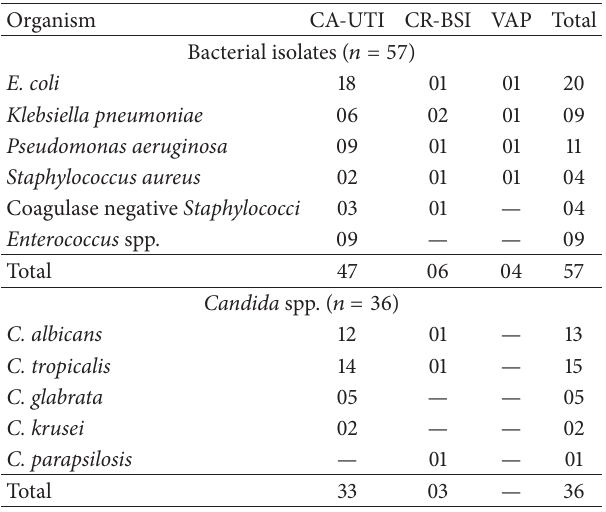
Table 2: Spectrum of microorganism isolated from medical device associated infections.